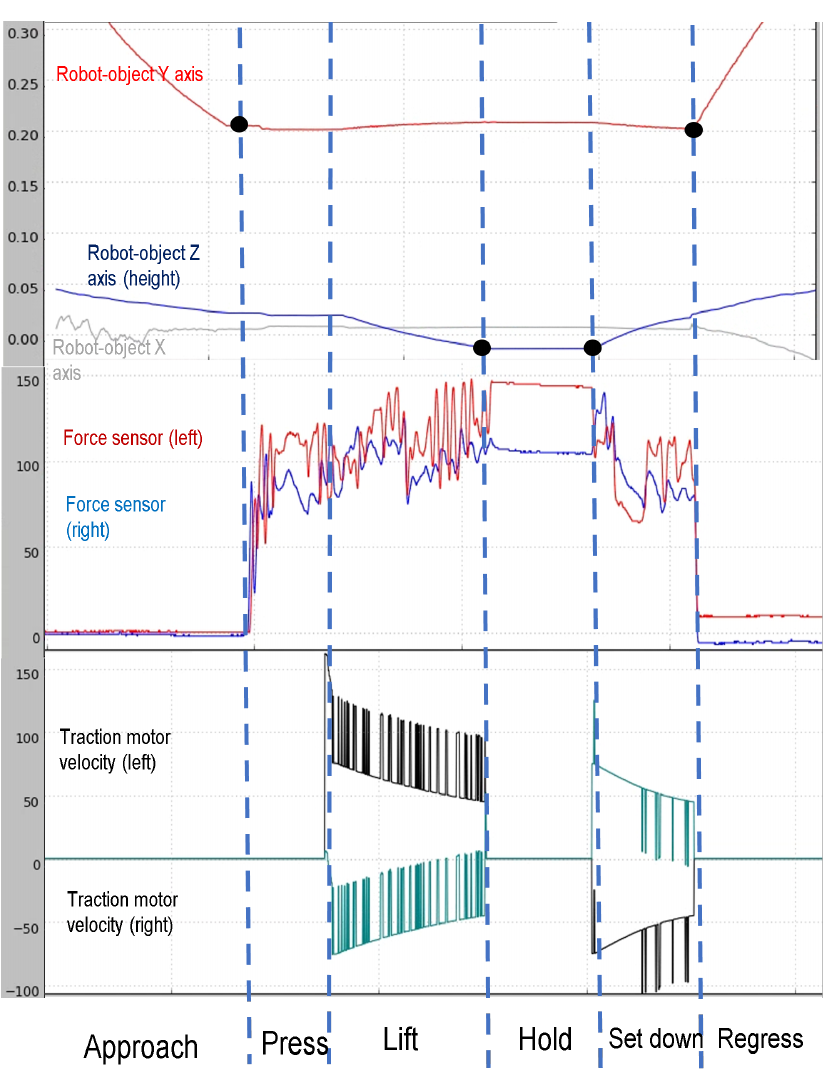
Figure 6. Experiment-1 execution